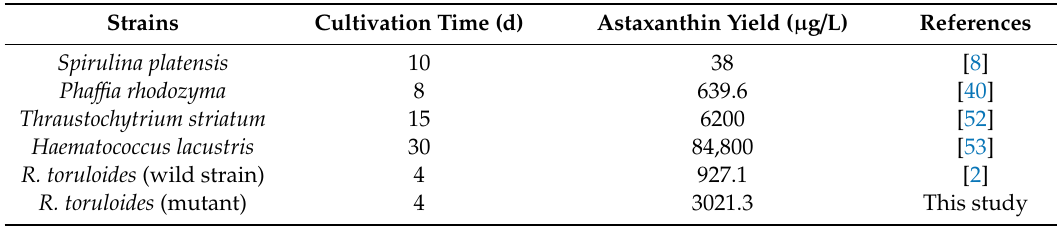
Table 7. Astaxanthin production by several